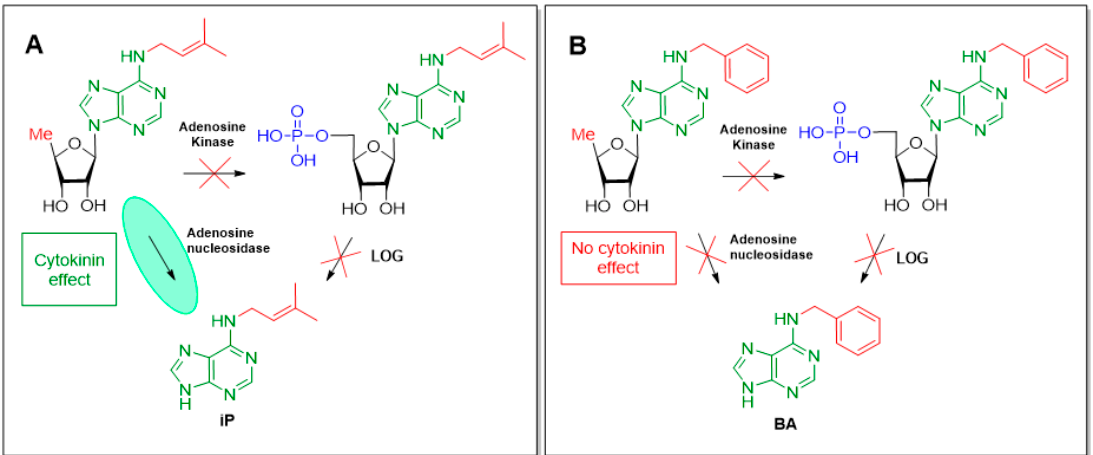
Figure 3. The e ff ect of structural modification of cytokinin nucleosides in Arabidopsis on the biosynthesis Figure 3. The effect of structural modification of cytokinin nucleosides in Arabidopsis on the pathways of iP ( A ) and BA ( B biosynthesis pathways of iP ( A ) and BA ( B ).